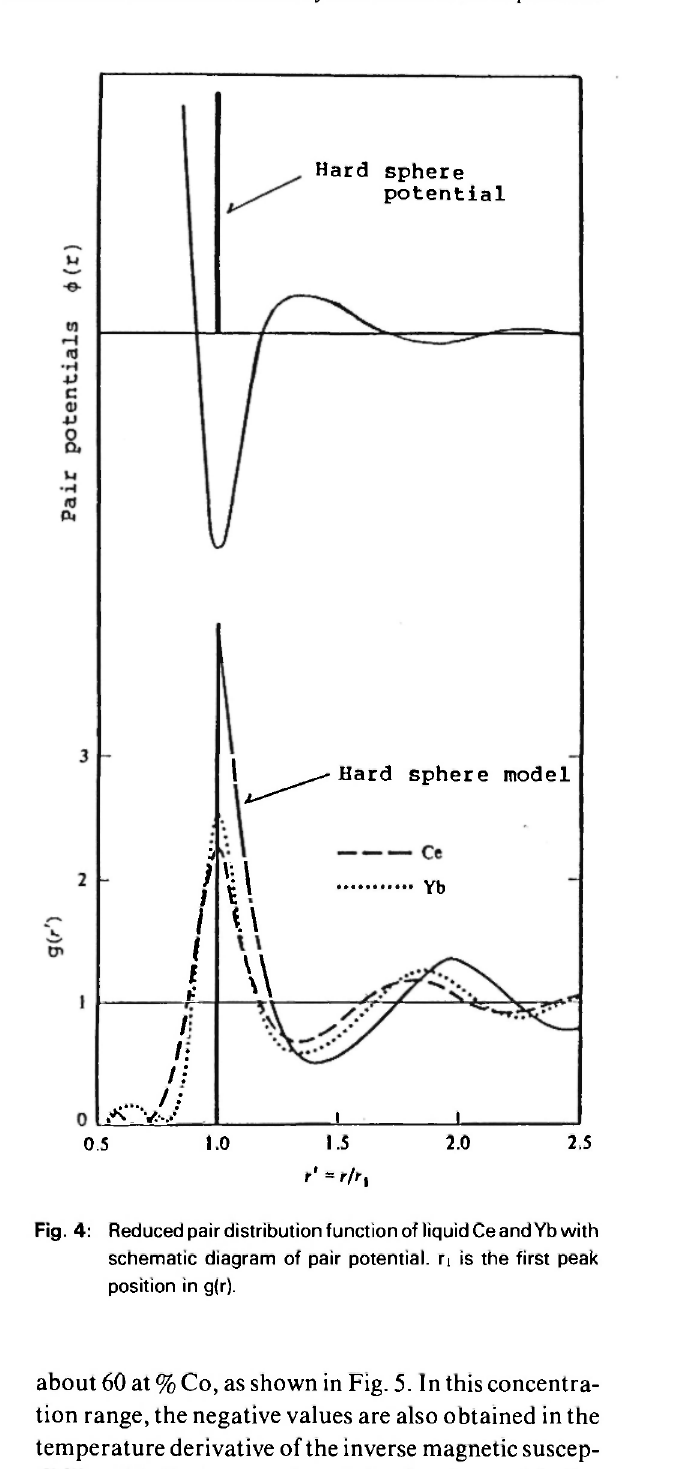
Fig. 4: Reduced pair distribution function of liquid Ce and Yb with schematic diagram of pair potential, η is the first peak position in